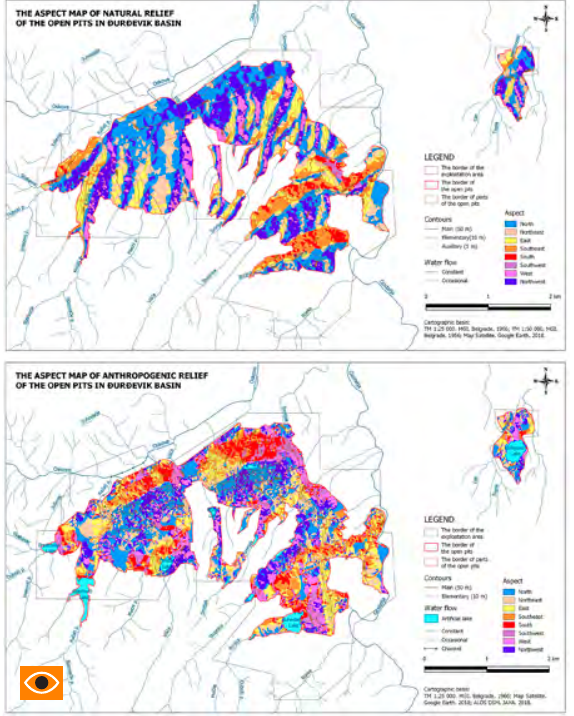
Figure 5. The aspect map of natural (up) and anthropogenic (down) relief of the study